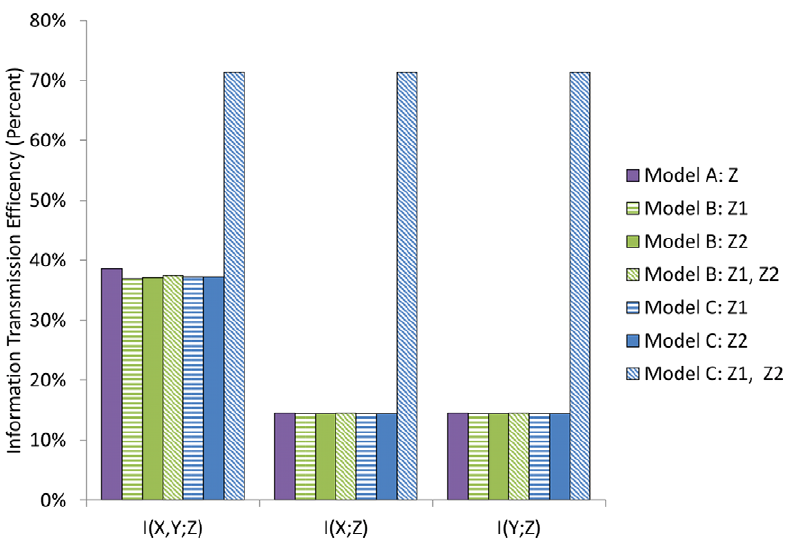
Figure 3. Summary of calculations of I ( X , Y; Z ) , I ( X; Z ) and I ( Y; Z ) for the three Smad pathway network topologies considered in this paper. Information transfer efficiency as a percentage of the total uncertainly in the external distribution of ligands is shown in the y -axis. Model A is the model with a single Smad ( Z ), Model B is the model with a RSmad ( Z 1 ) and a RSmad:Co-Smad heterodimer ( Z 2 ) while Model C refers to the model with two RSmad proteins ( Z 1 and Z 2 ). Information was calculated using either an individual output or both outputs (as is represented by Z1, Z2).